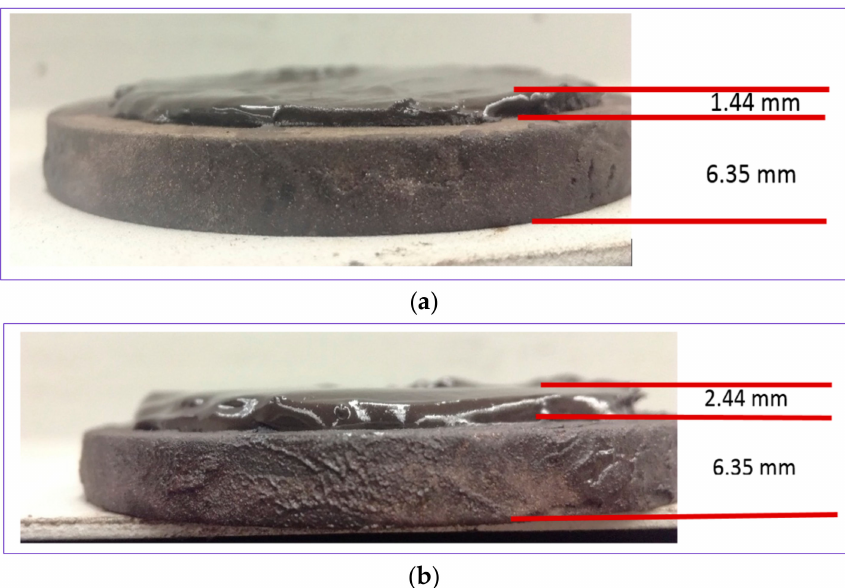
Figure 12. Effect of the copolymer on the filter cake thickness: ( a ) formed filter cake for the drilling fluid with the copolymer and ( b ) formed filter cake for the base drilling